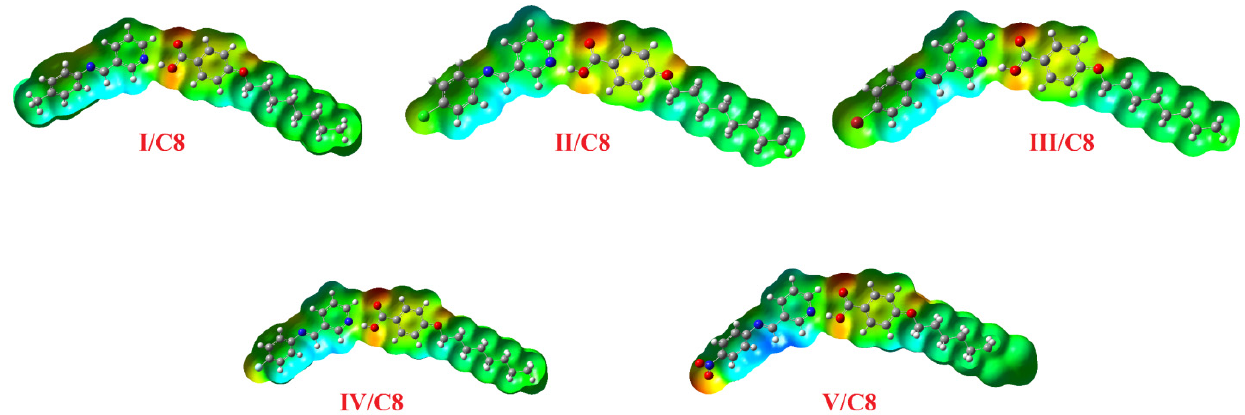
Figure 9. Molecular electrostatic potentials (MEP) for the para-octyloxy benzoic acid C8 supramolecular complexes prepared, ( I-V ) C8 , H (gray), C (black), N (blue) and O (red).